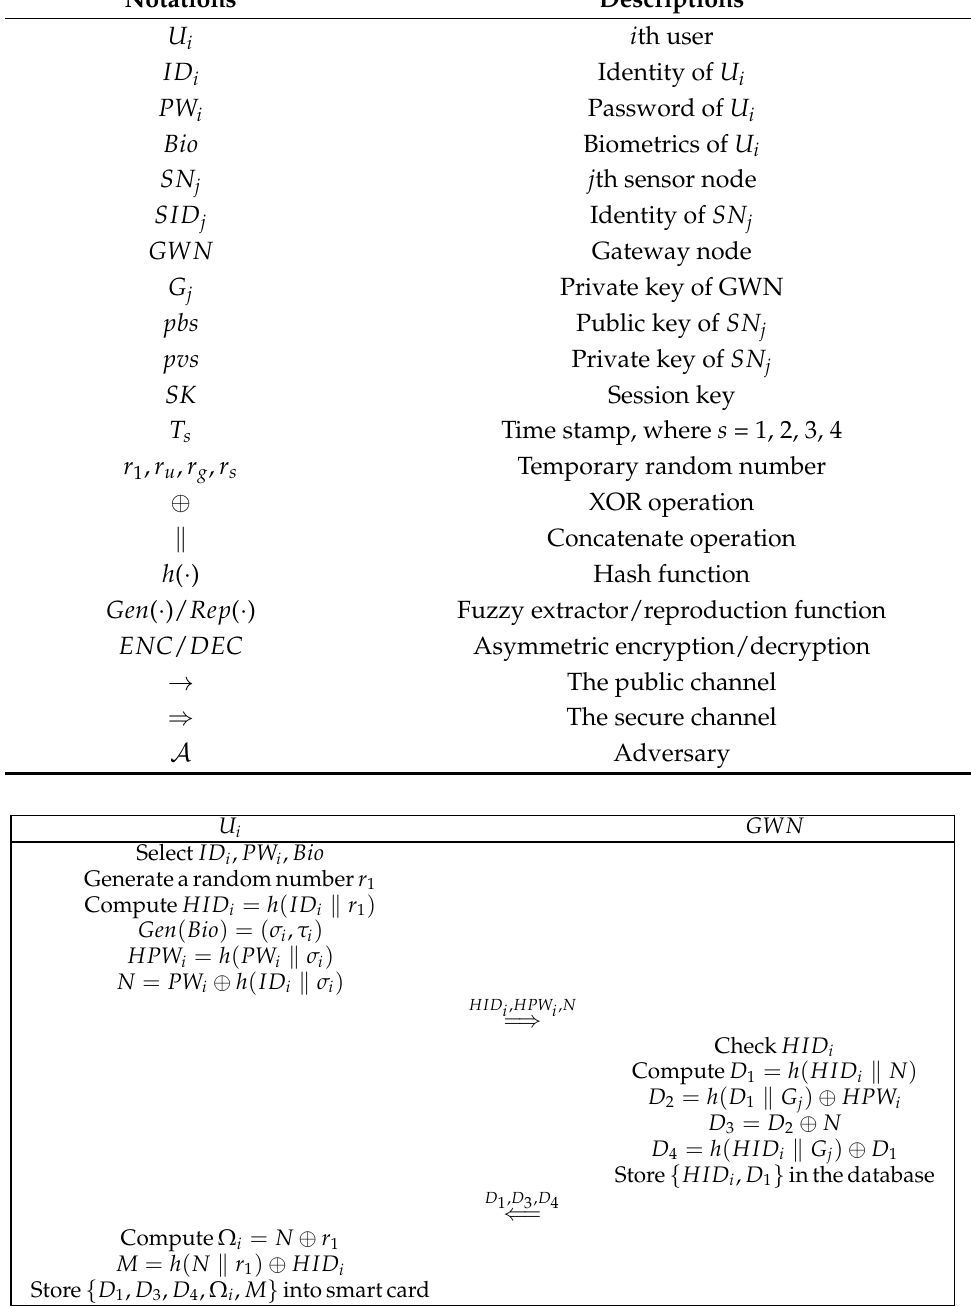
Figure 2. User registration phase